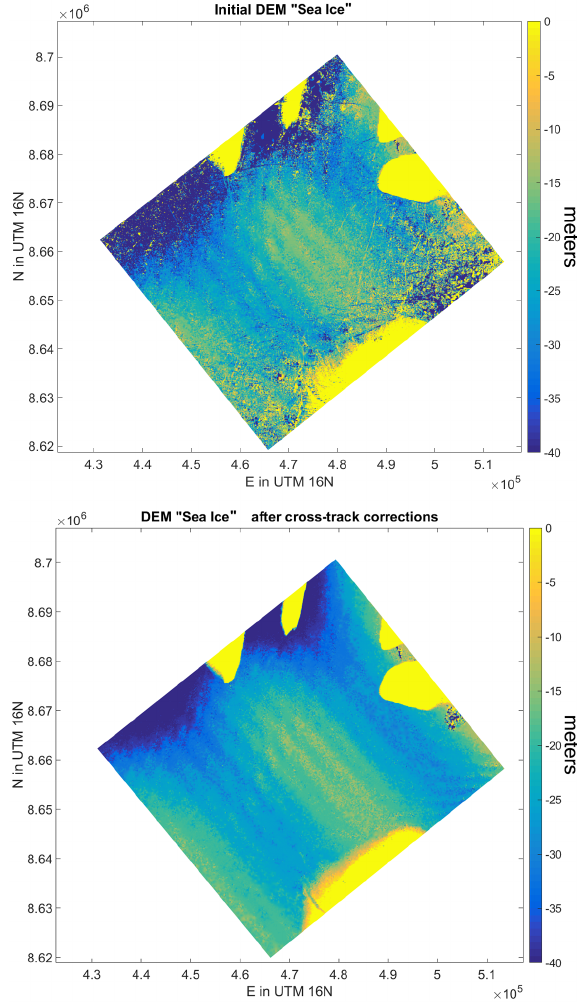
Figure 8: DEM product over the “Sea Ice” scene. Top : using only the metadata. Bottom : after correcting the cross-track par-